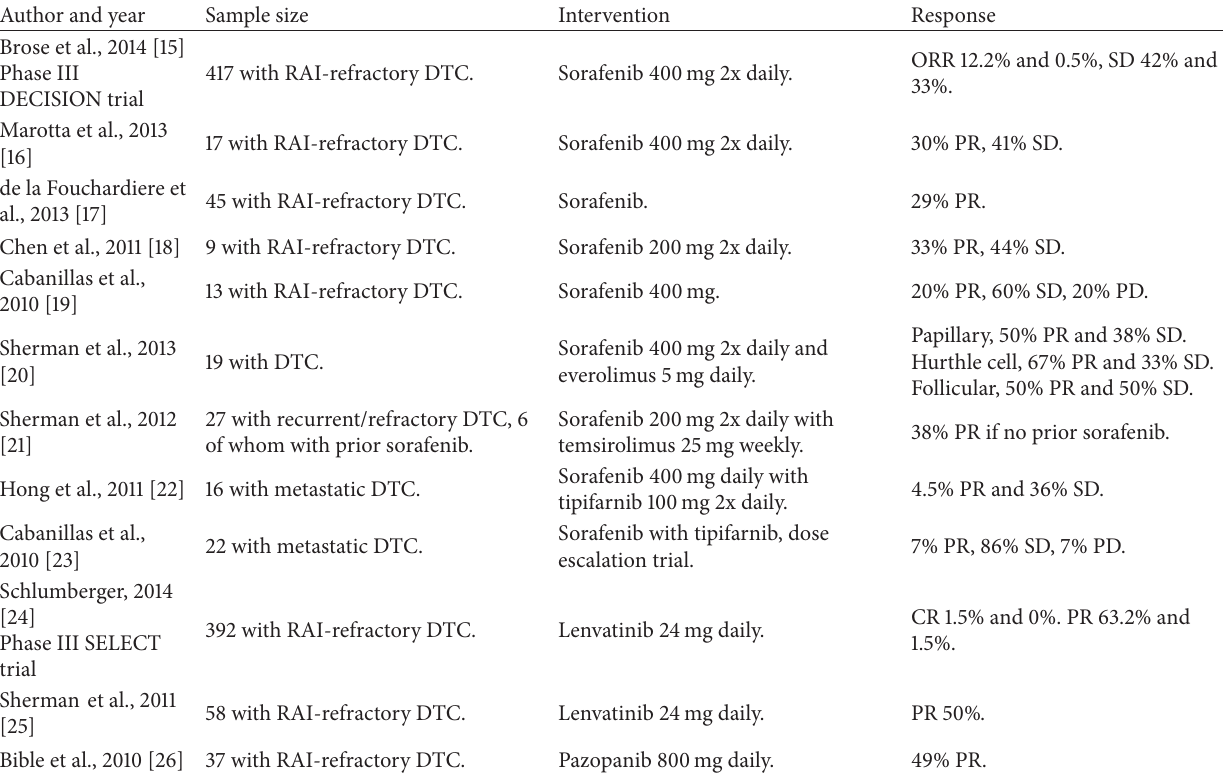
Table 4: Summary of studies of targeted therapy in differentiated thyroid cancer.